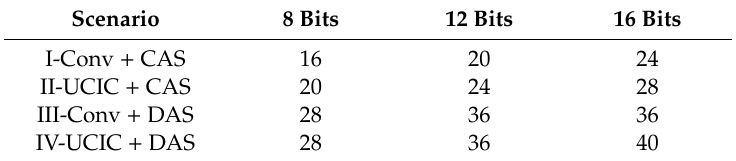
Figure 7. Achievable Channel State Information (CSI) feedback overhead reduction by UCIC strategy, under different amounts of UE and cluster size (C) of 2, 5, 10. Table 2. Number of transmit antennas that can be deployed in different scenarios.